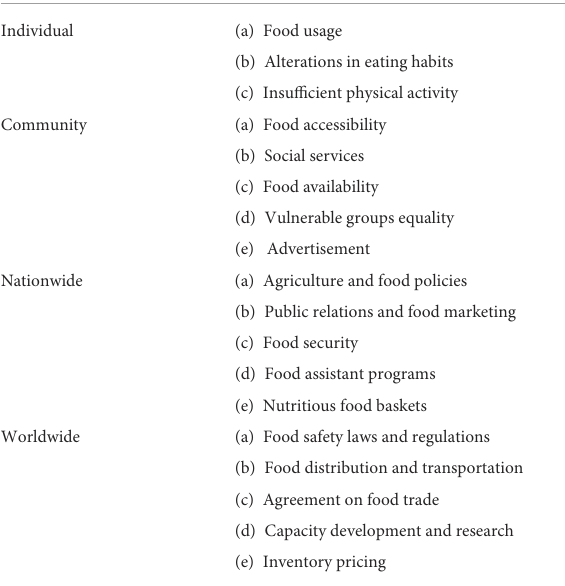
TABLE 4 Multilevel framework to promote nutrition and food security during the COVID-19 pandemic. Multilevel